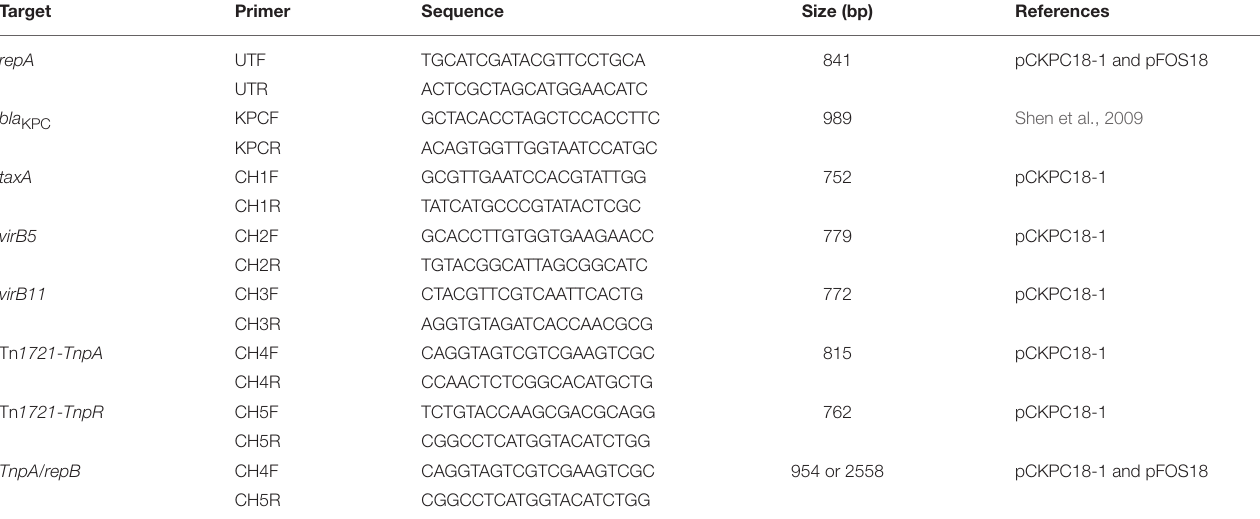
TABLE 1 | Multilocus-PCR primers used in this